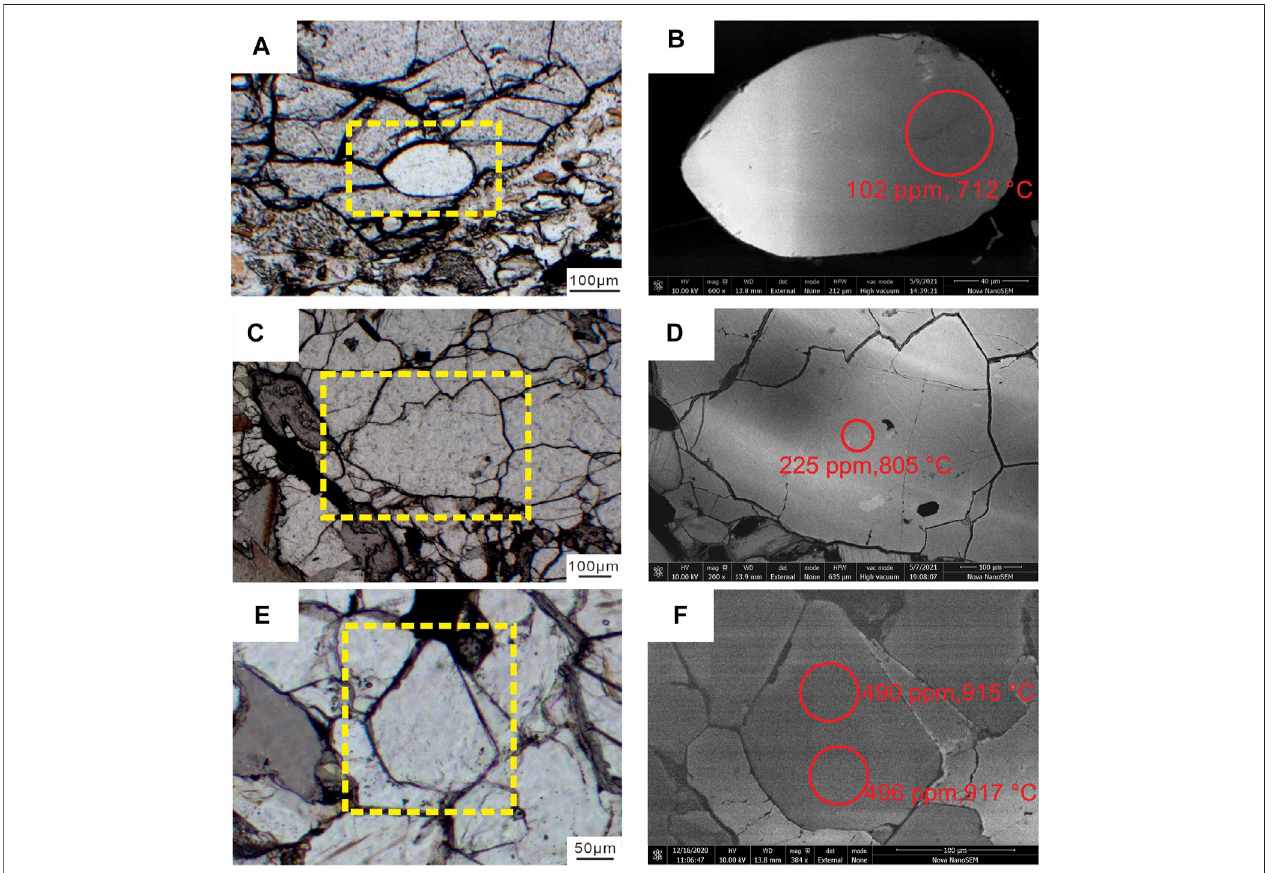
FIGURE 6 | Representative photomicrographs and CL images of the analyzed quartz grains showing non-structure with homogeneous luminescence. (A) Quartz inclusion within garnet rim in sample 20HL101, and CL image is shown in (B) ; (C,E) Matrix-type quartz in samples 09XH07 and 09JGQ15, and CL images are shown in (D,F) , respectively. The red circle marks the analyzed EPMA